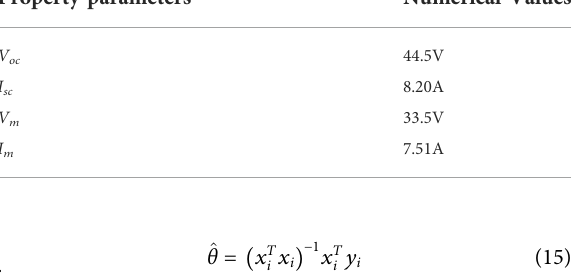
TABLE 1 PV cell